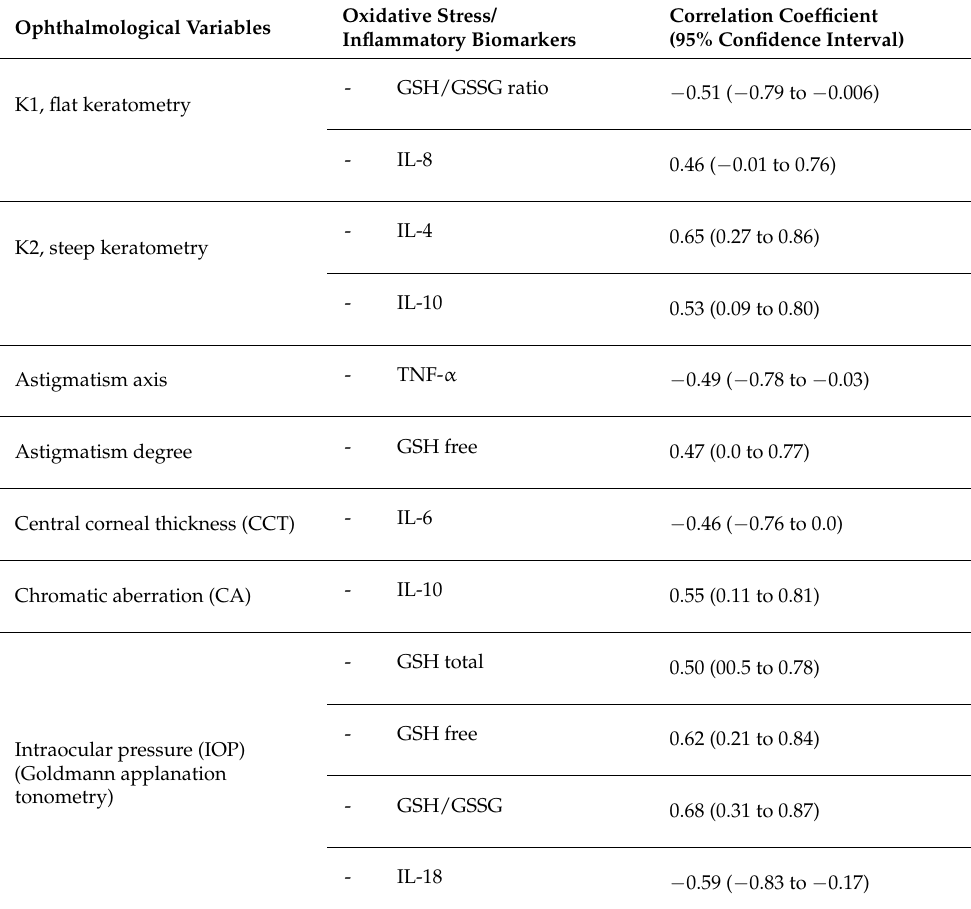
Table 6. Correlations between ophthalmological parameters and biomarkers of oxidative stress and inflammation in patients with keratoconus treated with DHA supplementation. Oxidative Stress/ Correlation Coefficient Ophthalmological Variables Inflammatory Biomarkers (95% Confidence